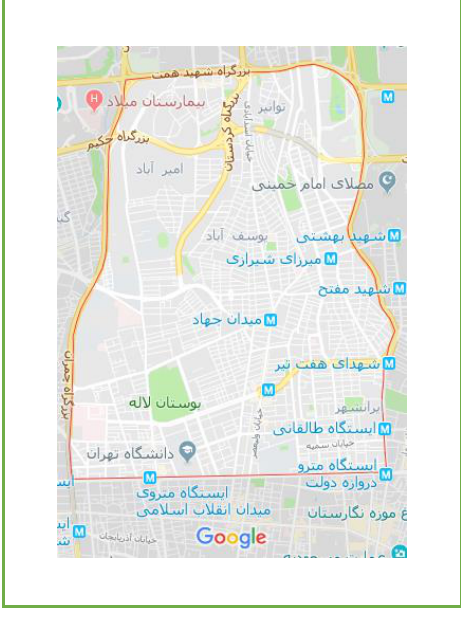
Figure2. District 6 of Tehran province